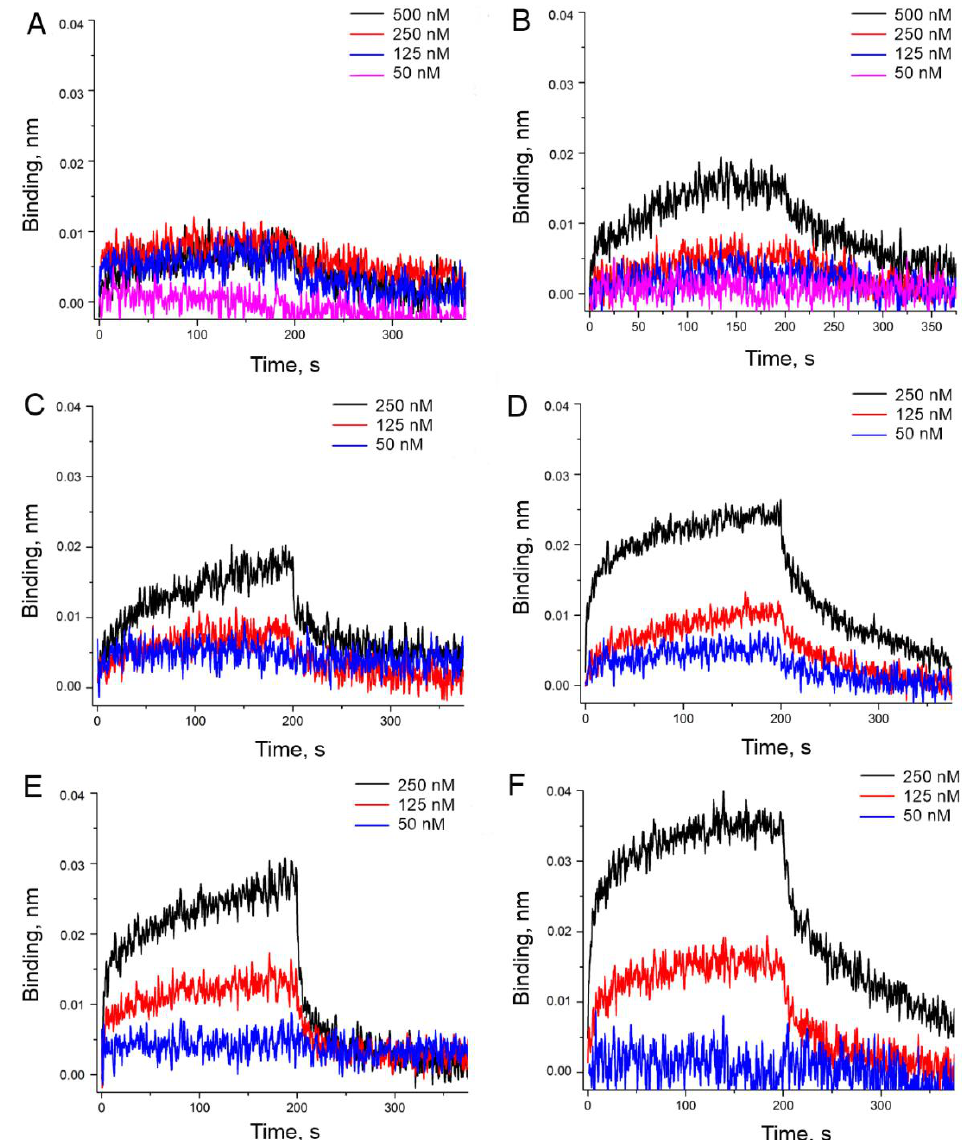
Figure 5. Binding of the amino-modified aptamers to thrombin: ( A , B ) amino-T4,T13-HD1; ( C , D ) amino-T13-HD1; ( E , F ) amino-T3,T12-HD1. The aptamer assembly and the binding experiments were carried out in ‘potassium buffer’ with 10 mM K + and 140 mM Na + ( A , C , E ) or in ‘sodium buffer’ with 140 mM Na + ( B , D , F ). The association stage was 200 s long; the dissociation stage was 300 s long. The color scheme of Table 3 clearly shows the effect of the introduced Table 3. The characteristics of the aptamer – thrombin complexes, namely, dissociation constants (K D ), kinetic association constants (k on ), and kinetic dissociation constants (k off ). The experiments were carried out in two buffer systems, with and without K + , that greatly affect the stability of the G-quadruplex structure. The colored cells refer to more than a 2-fold increase (green color) or de- crease (orange color) in affinity. n.d.: not determinable.